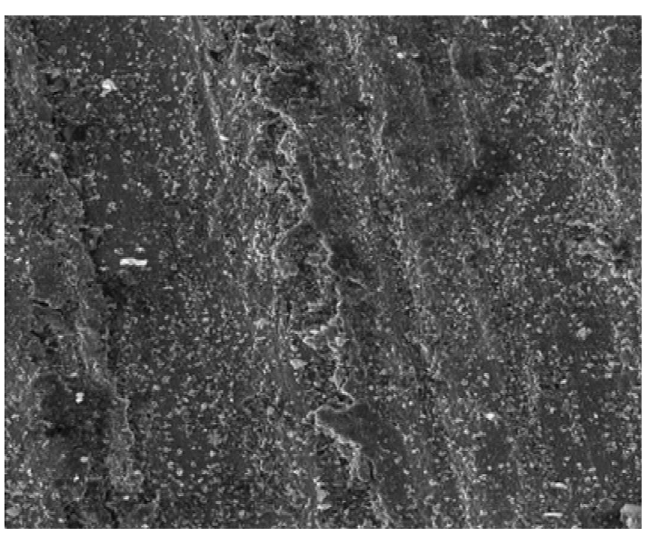
Figure 11. SEM microstructure of grey cast iron carburized at 900 °C for 120